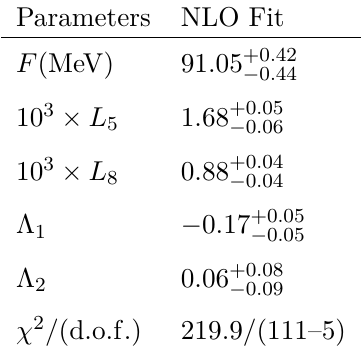
Table 1 . The values of the LECs from the NLO